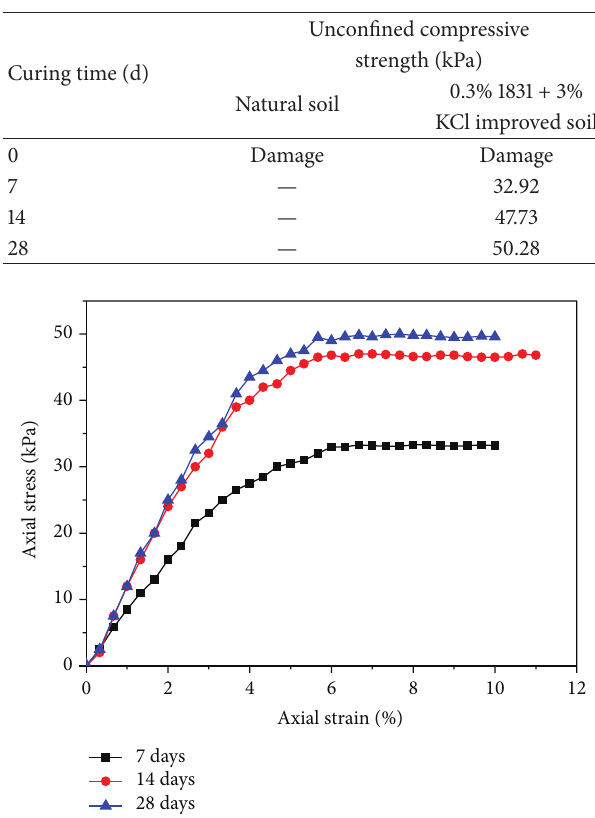
Figure 1: Unconfined compressive strength curves of improved soil with axial strain under different curing